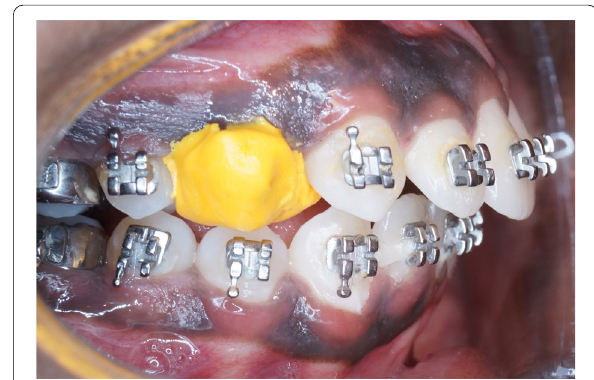
Fig. 2 Putty shielded premolar to prevent enamel surface alterations from extraction forceps